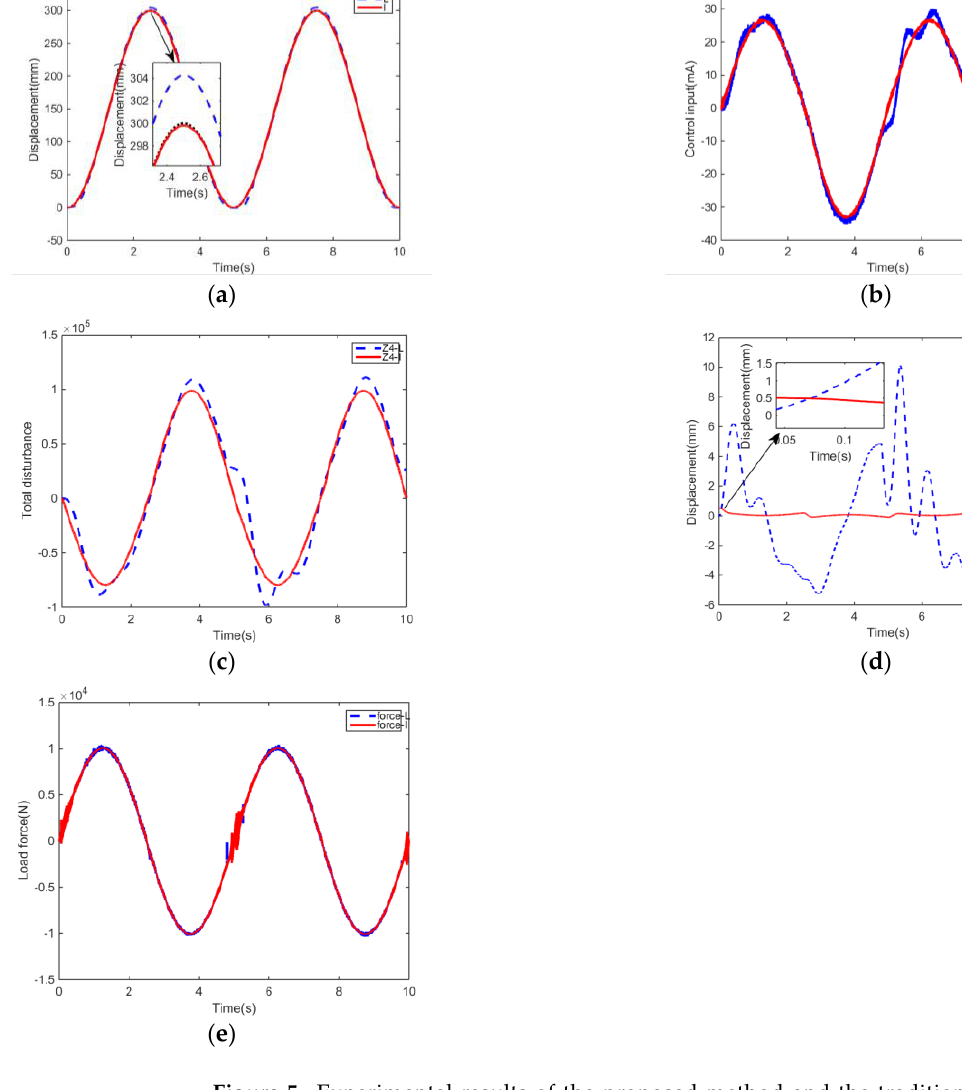
Table 3. Comparison of experimental results.